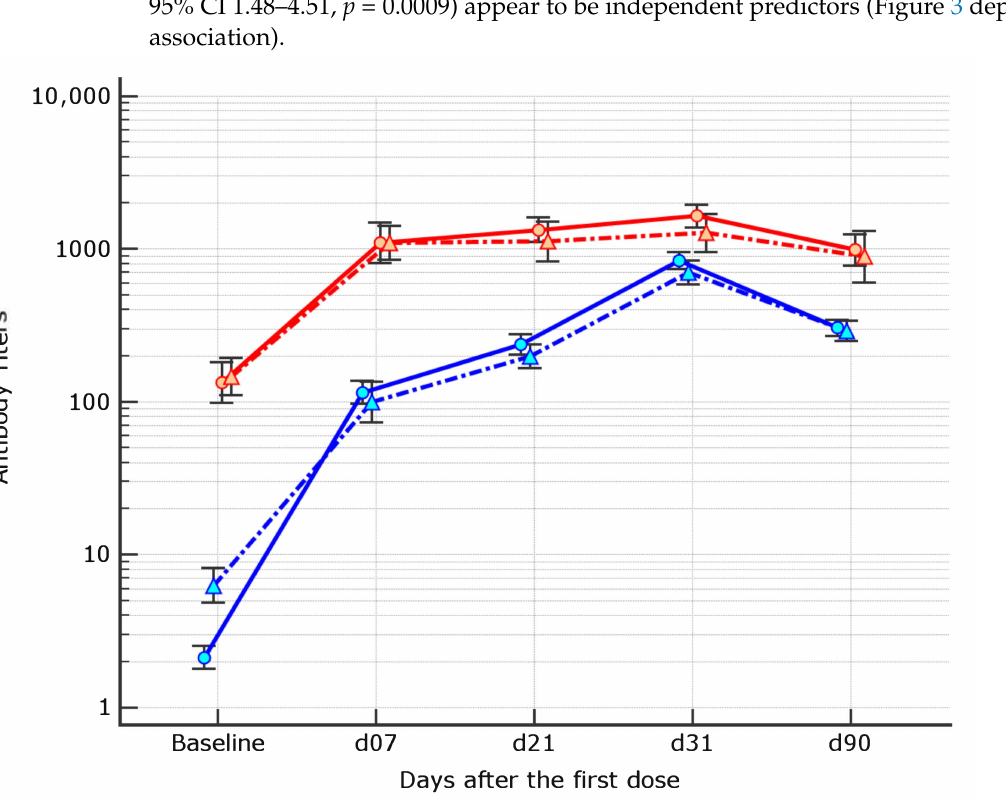
Figure 3. Geometric mean antibody titers kinetics in healthcare workers by prior COVID-19 experience and gender from baseline to 90 days after the first BNT162b mRNA dose (red line = COVID-19 experienced, blue line = COVID-19 naive). The highest threshold of the assay is 35.200